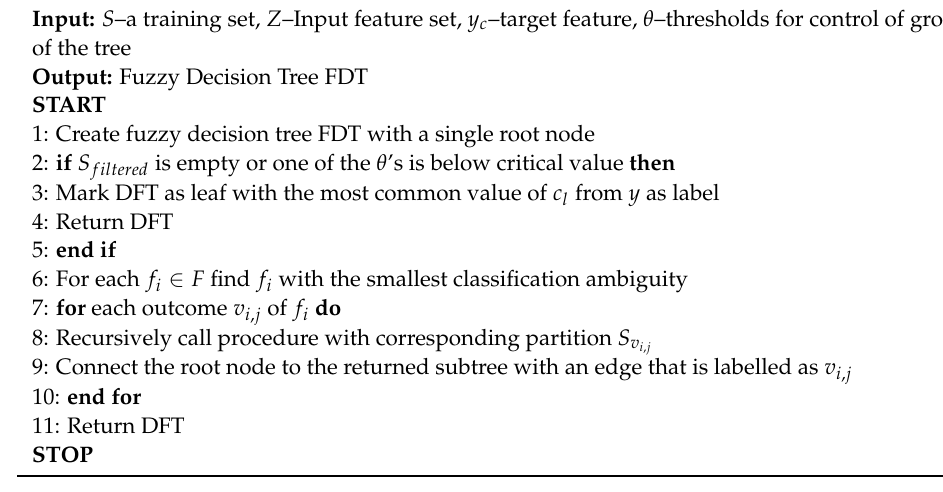
Algorithm 1. Algorithm for fuzzy decision tree